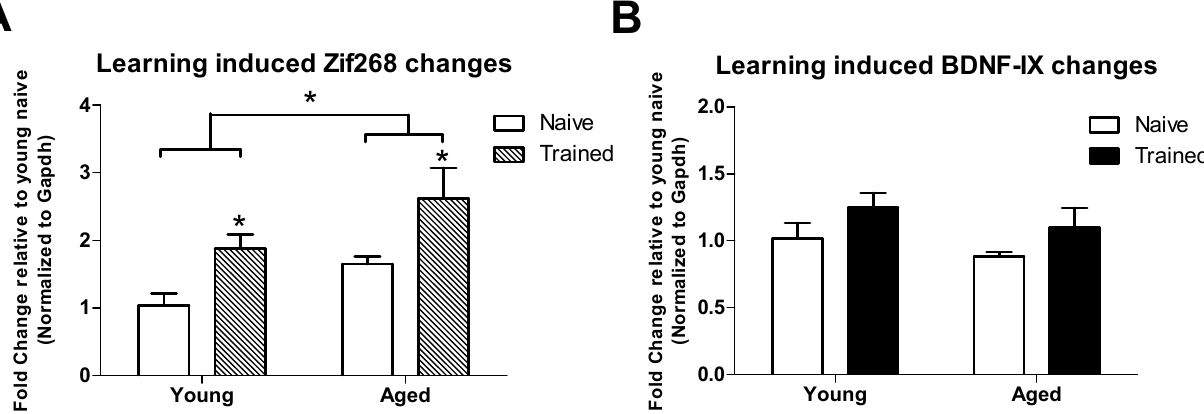
Figure 3. Learning induced changes in memory related gene expression in area CA1 of aged adults. Young and aged adults were sacrificed from their home cages (Naïve) or 1 h after training in NOR (Trained). H3K4me3 and H3K9me2 were assessed in hippocampal regions CA1. ( A ) Zif268 mRNA levels are significantly increased after NOR training; ( B ) Bdnf mRNA levels were not significantly altered with training. Results are presented relative to young-naïve adults. Group sizes : young naïve, n = 4; young trained, n = 6; aged naïve, n = 4; aged trained, n = 6. Two-Way ANOVA ; * p < 0.05. Data are shown ±